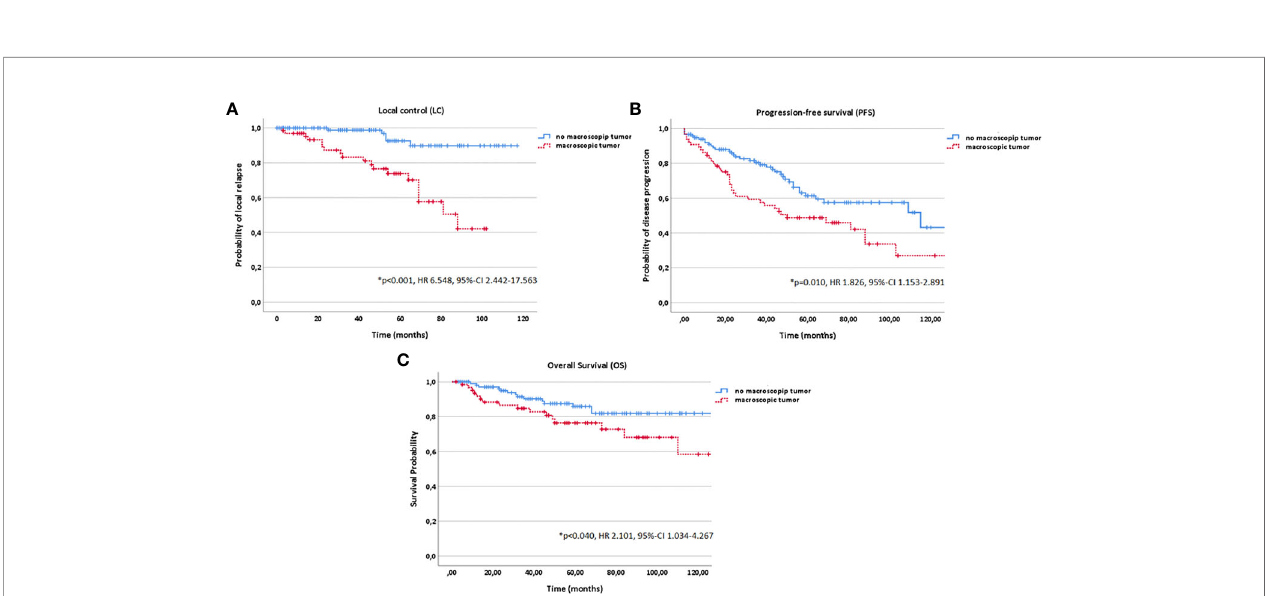
FIGURE 5 | Kaplan-Meier estimates for local control (A) , progression-free survival (B) and overall survival (C) in dependence of macroscopic tumor diagnosed in a pretreatment magnetic resonance imaging (MRI) before radiotherapy (RT) start (yes vs.